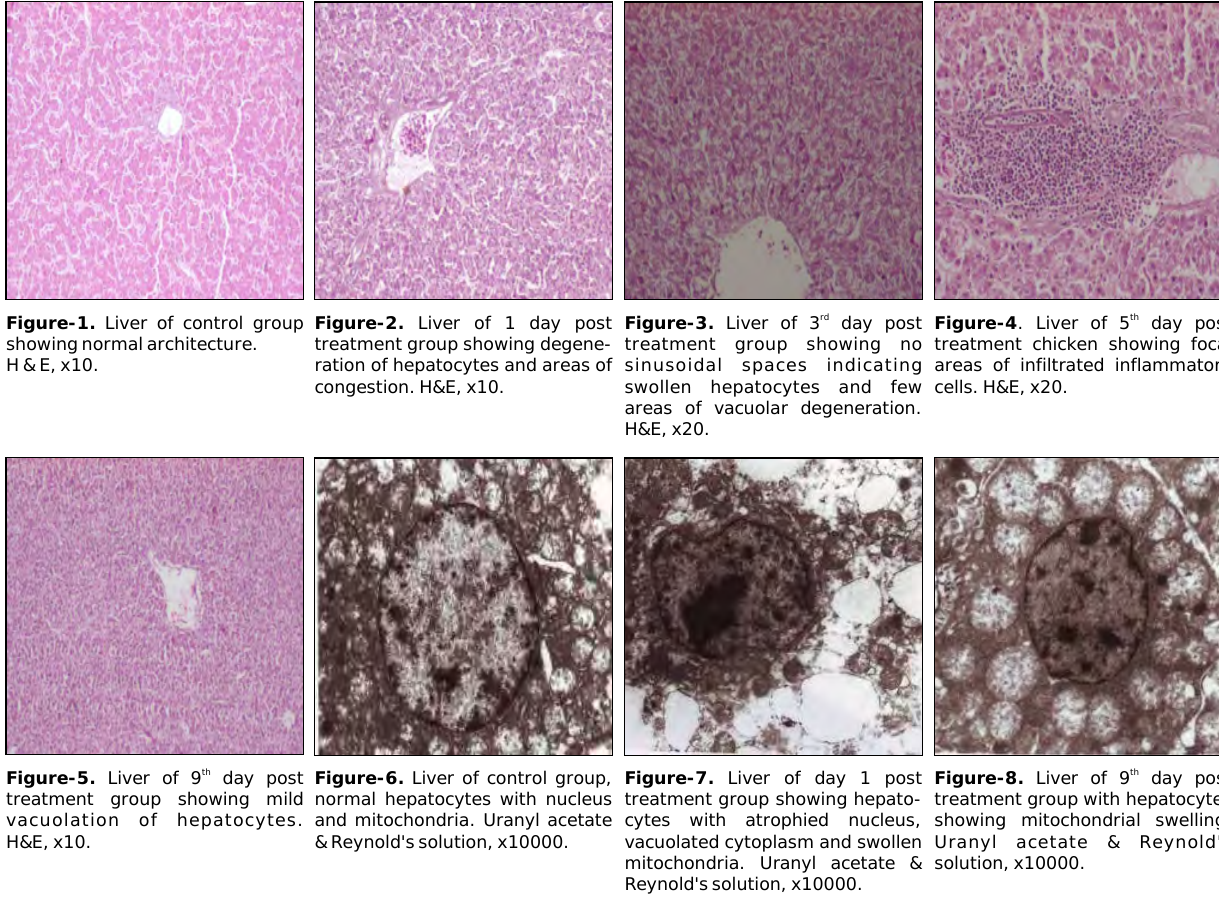
th Figure-5. Liver of 9 day post Figure-6. Liver of control group, treatment group showing mild normal hepatocytes with nucleus vacuolation of hepatocytes. and mitochondria. Uranyl acetate H&E, x10. & Reynold's solution, x10000.